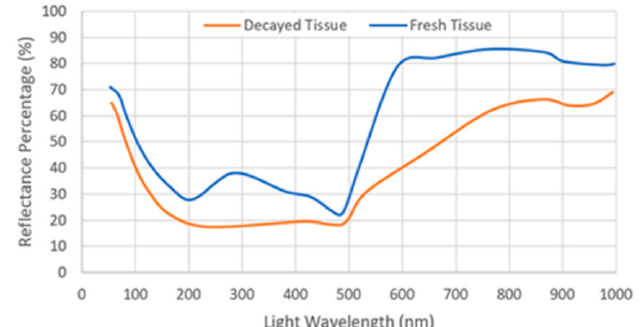
Figure 4. Reflectance for fresh and decayed tissue versus wavelengths. (Regenerated with permission from Postharvest Biology and Technology journal [59]).